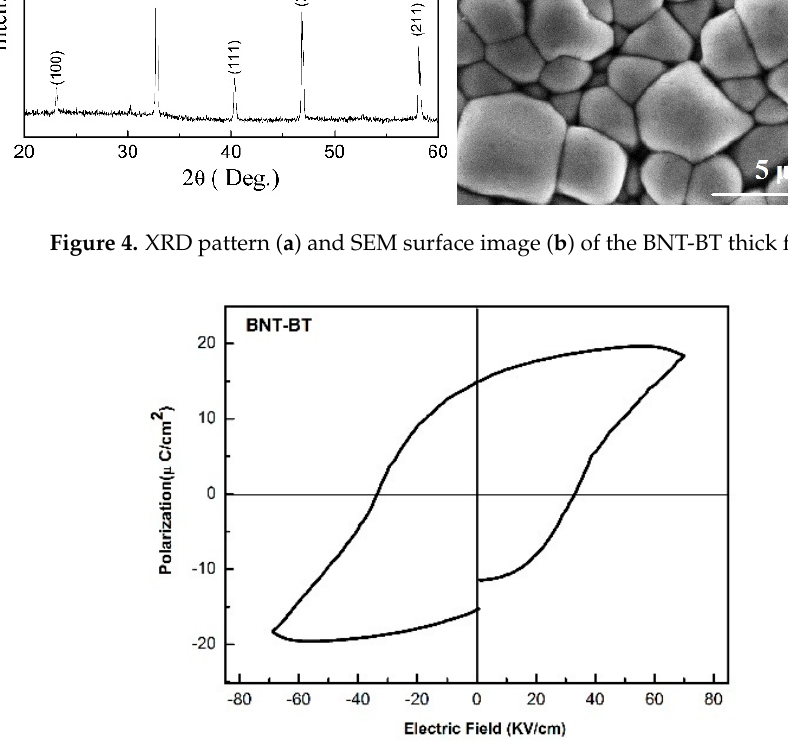
Sensors 2018 , 18 , x FOR PEER REVIEW 5 of 9